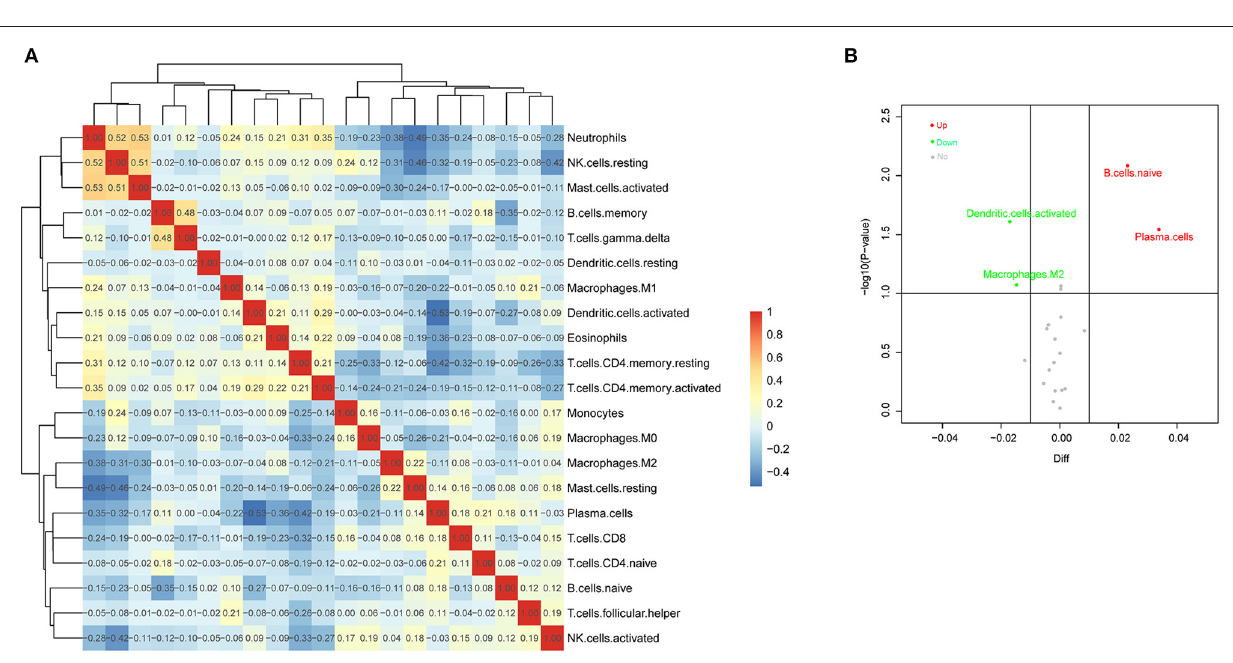
inflammatory pathways were involved in multiple